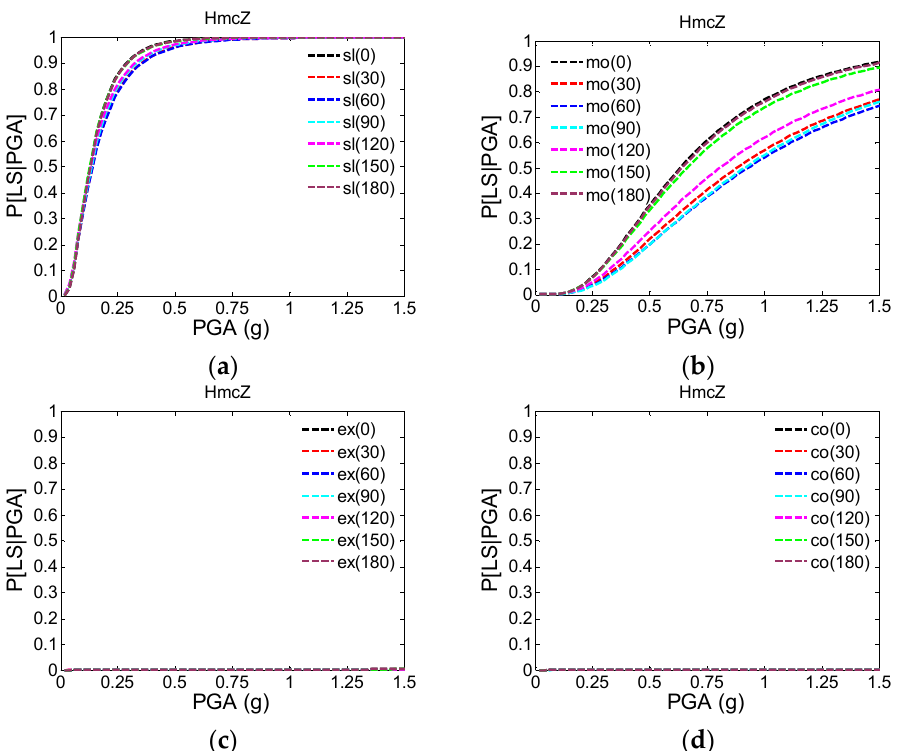
Figure 9. Seismic fragility curves of HmcZ subjected to different excitation angles in the ( a ) slight; ( b ) moderate; ( c ) extensive; and ( d ) complete limit states.